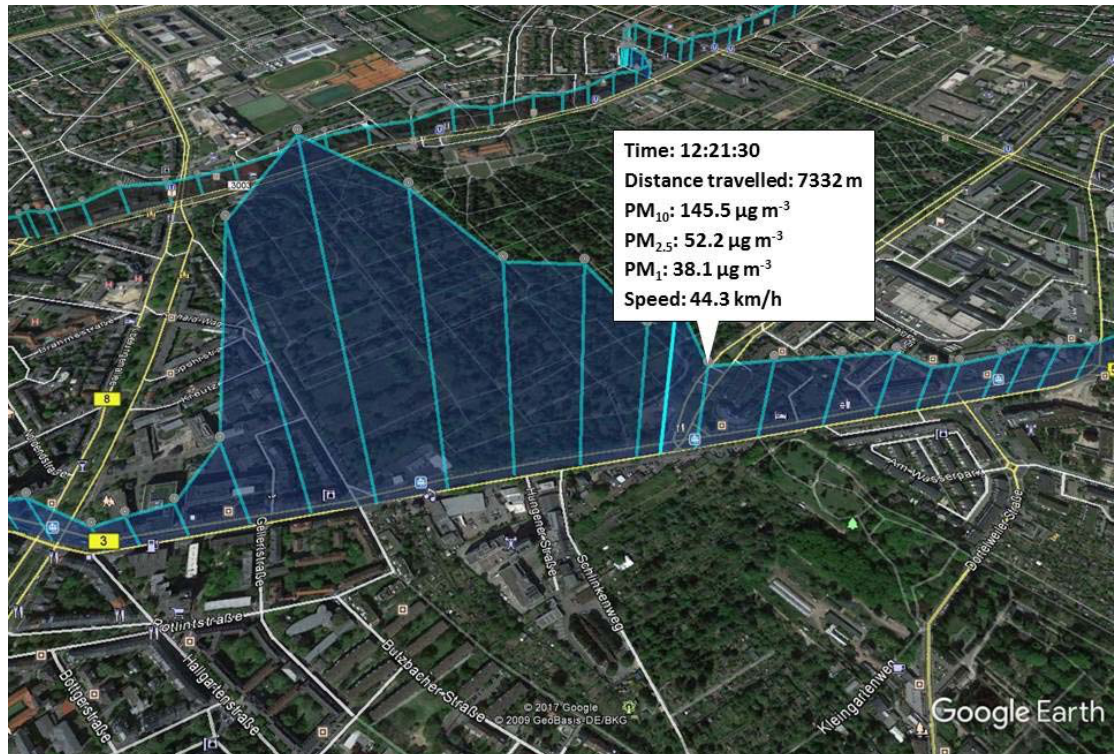
Figure 1. kml file with the local in-cabin particulate matter (PM) concentration measured while driving through Frankfurt am Main. Turquoise line: Location-dependent PM concentration. Geographical picture by Google Earth.